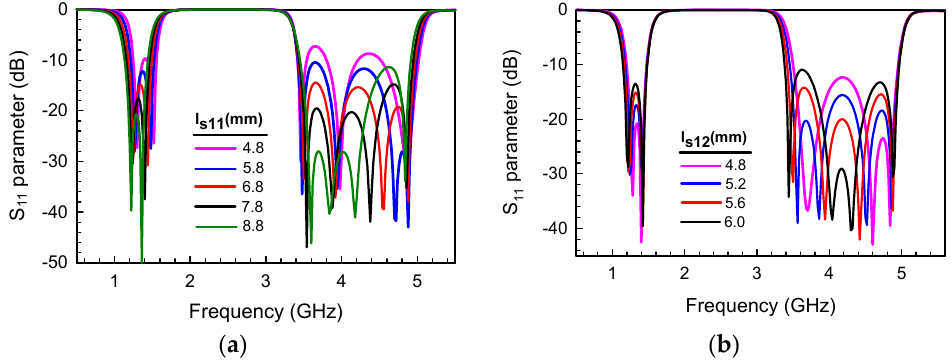
Figure 16. Variation in return loss levels versus different lengths of ( a ) l s11 = l s22 , ( b ) l s12 = l s21 . The bandwidths of the filter can be controlled on both sides of the passbands by changing the length of the stubs between the resonators ( l s12 = l s21 ) and distances between the square loop resonator and a short-circuited stub ( d l12 = d l21 ). When l s12 and l s21 simulta- neously range from 4.2 mm to 6.6 mm, the bandwidths of the first and second passbands increase from 400 MHz to 520 MHz and from 1600 MHz to 1780 MHz, respectively. In this manner, the bandwidth increases from the left side for both passbands, as demonstrated in Figure 17a. Similarly, by decreasing d l12 and d l21 from 3.8 mm to 2.2 mm, the bandwidths of the first and second passbands increase from 440 MHz to 520 MHz and from 1670 MHz to 1750 MHz, respectively. It is clearly seen that the bandwidth increases only from the right side in Figure 17b. Significant bandwidth enhancement and control can be achieved for both passbands as depicted in Figure 17.